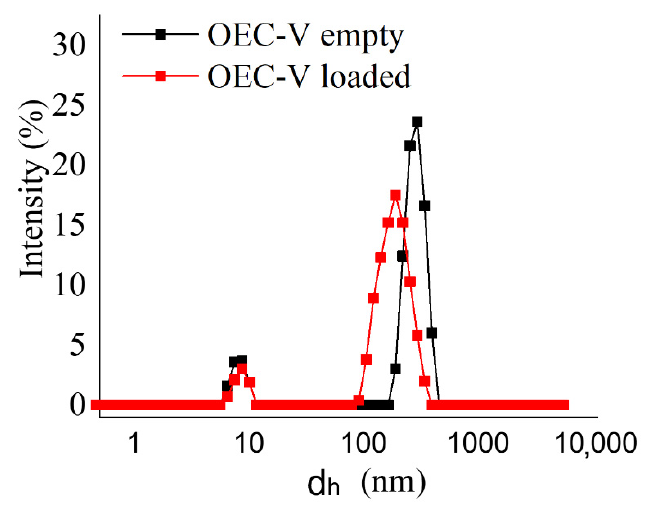
Figure 7. Size distribution curves of non-loaded and silibinin-loaded supramolecular OEC-V aggregates.